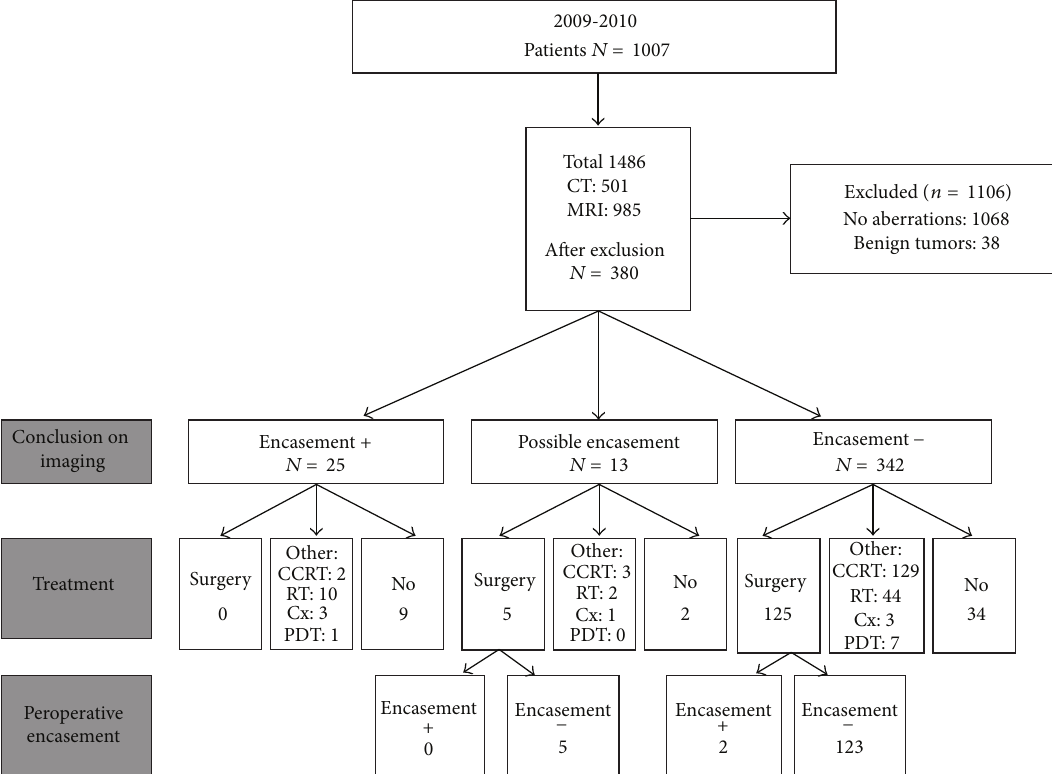
Figure 2: Retrospective analysis of all MR and CT images from 2009 to 2010. CCRT: concomitant chemoradiation therapy, RT: radiotherapy, Cx: chemotherapy, and PDT: photodynamic therapy. This figure shows 1486 MR and CT studies performed in 1007 patients between 2009 and 2010. In 1068 cases no aberrations were found, and in 38 cases there were only benign tumors. In 25 cases encasement ( > 270 degrees encasement) was present at preoperative assessment. In 13 cases the report was not conclusive, and in 342 cases no encasement was seen. During operation in 2/125 = 1.6% cases, encasement of the internal carotid artery was found.